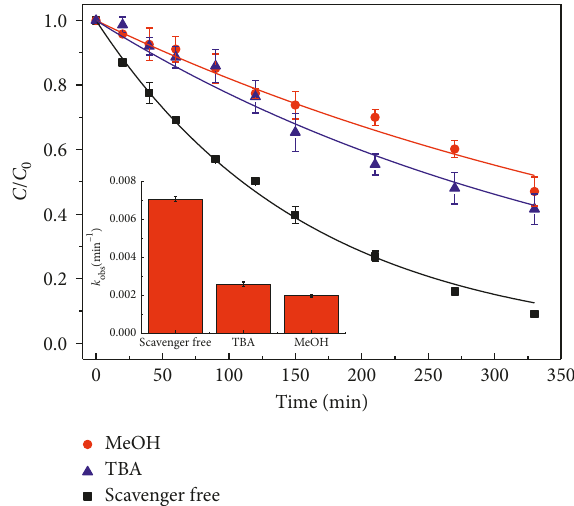
Figure 10: EPR spectrum of radical adducts in the TAP system. DMPO-OH, DMPO-SO [DMPO]